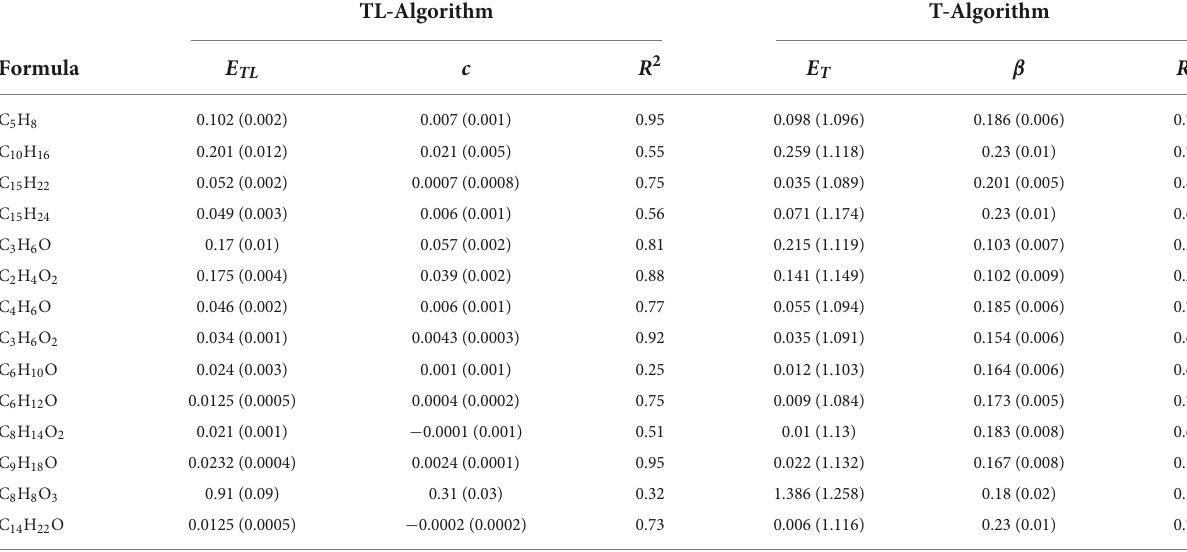
TABLE 2 Emission potentials of different compounds calculated using temperature ( E T ) and temperature-light algorithm ( E TL ) in µ gg − 1 h − 1 .